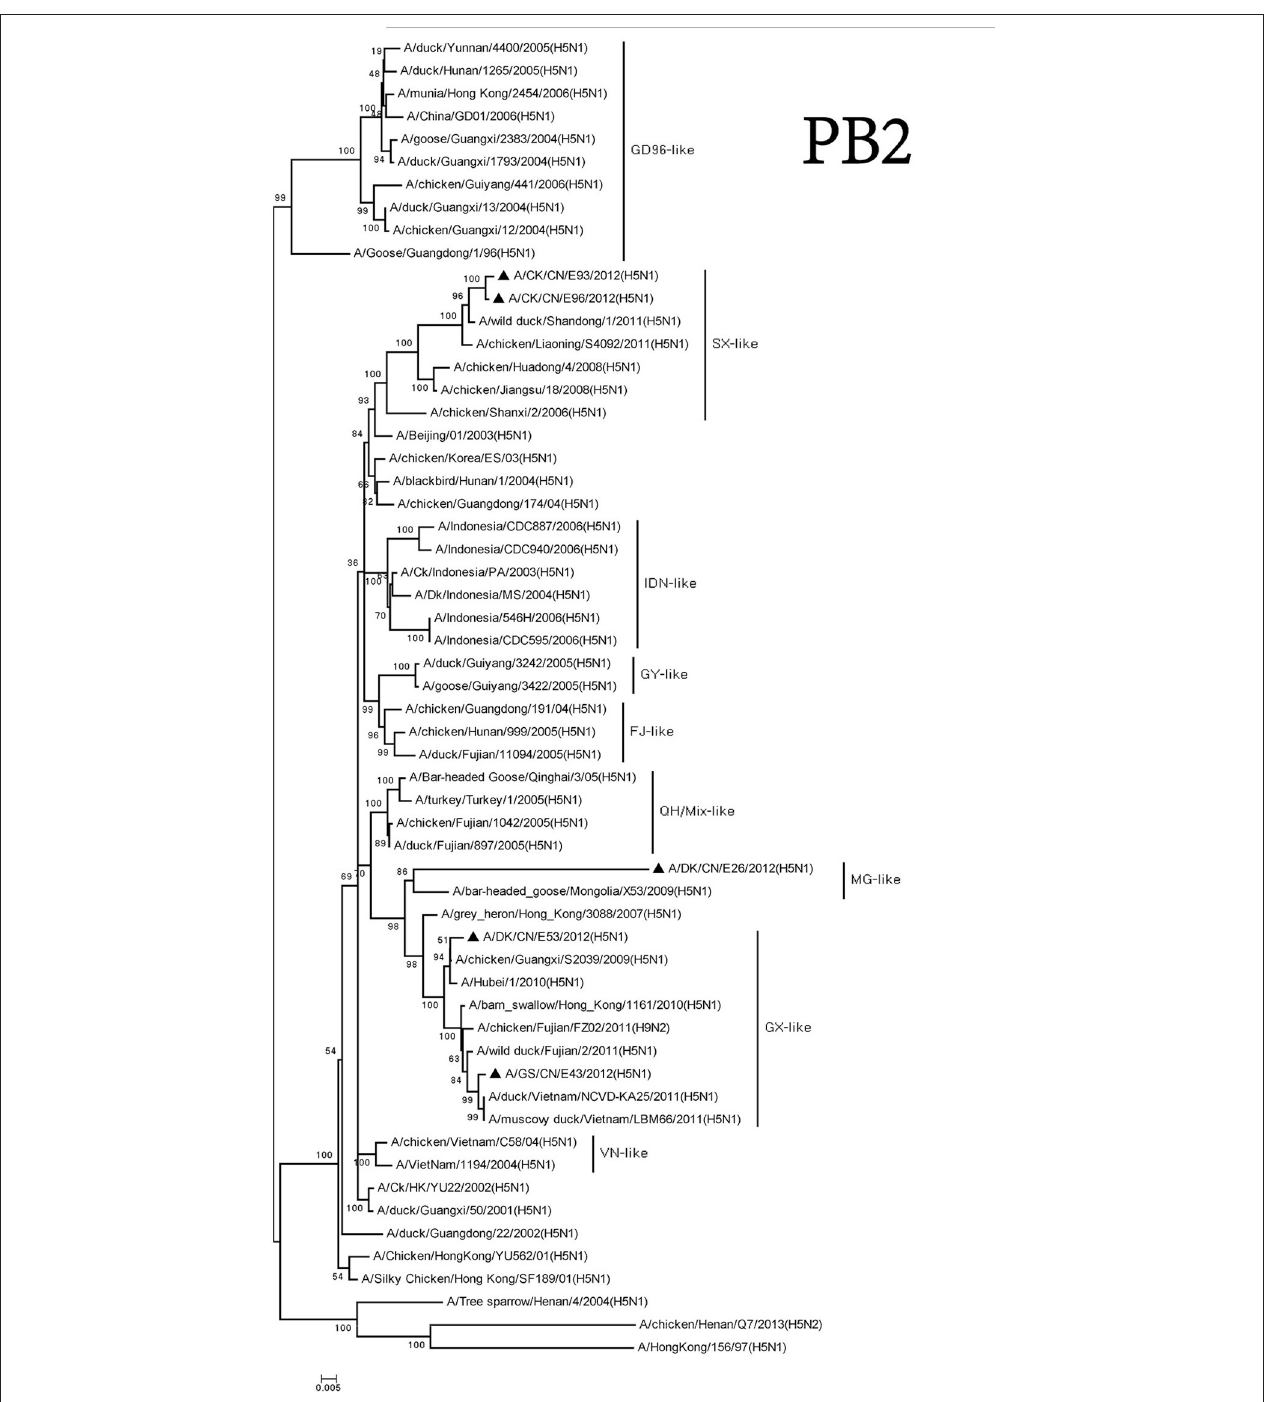
FIGURE 5 | Phylogenetic analysis of PB2. PB2: nt 28–230. Except our isolate, other virus sequences were downloaded from GenBank. QH, Qinghai; VN, Vietnam; IDN, Indonesia; GY, Guiyang; MG, Mongolia; GX, Guangxi; HD, Huadong; SX, Shanxi.